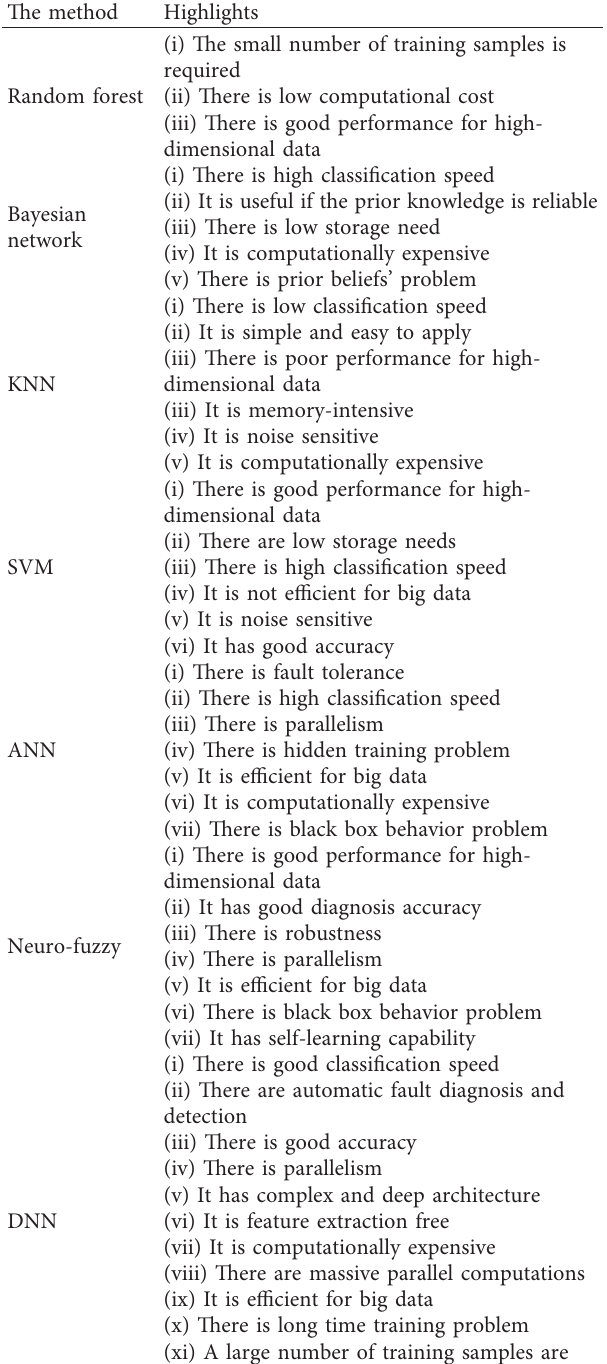
Table 3: AI algorithms used in CM and FDD of IM. The method Highlights Random